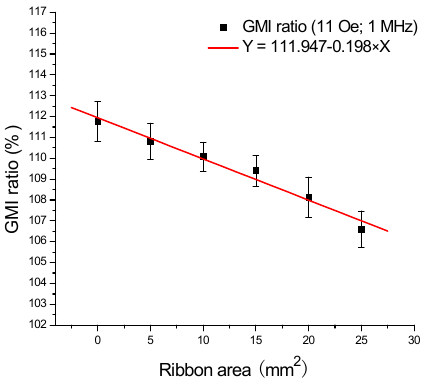
Figure 7. The calibration plots of the giant magnetoimpedance ratio versus the ribbon area when the ribbons are tested in front of the giant magnetoimpedance sensor I.